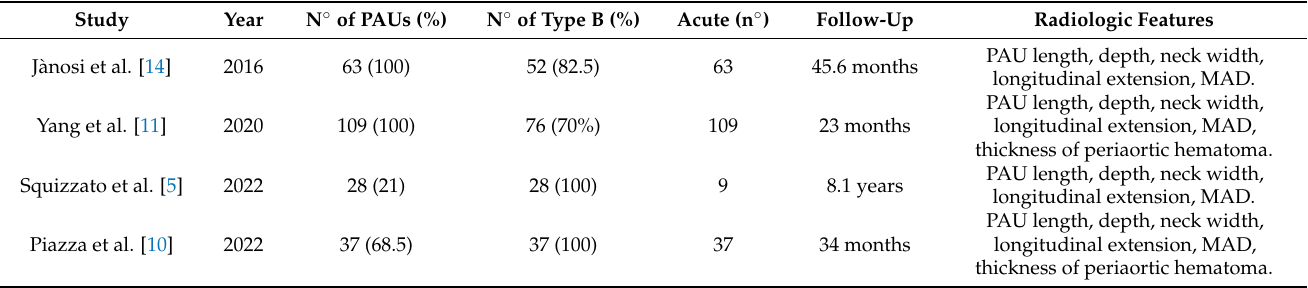
Table 1. Baseline characteristics of studies on penetrating aortic ulcers (PAU). Type B includes locations in the descending and abdominal aorta. All imaging markers that have been tested in order to identify an association with aortic-related adverse events are listed in the “radiologic features” column. MAD: maximum aortic